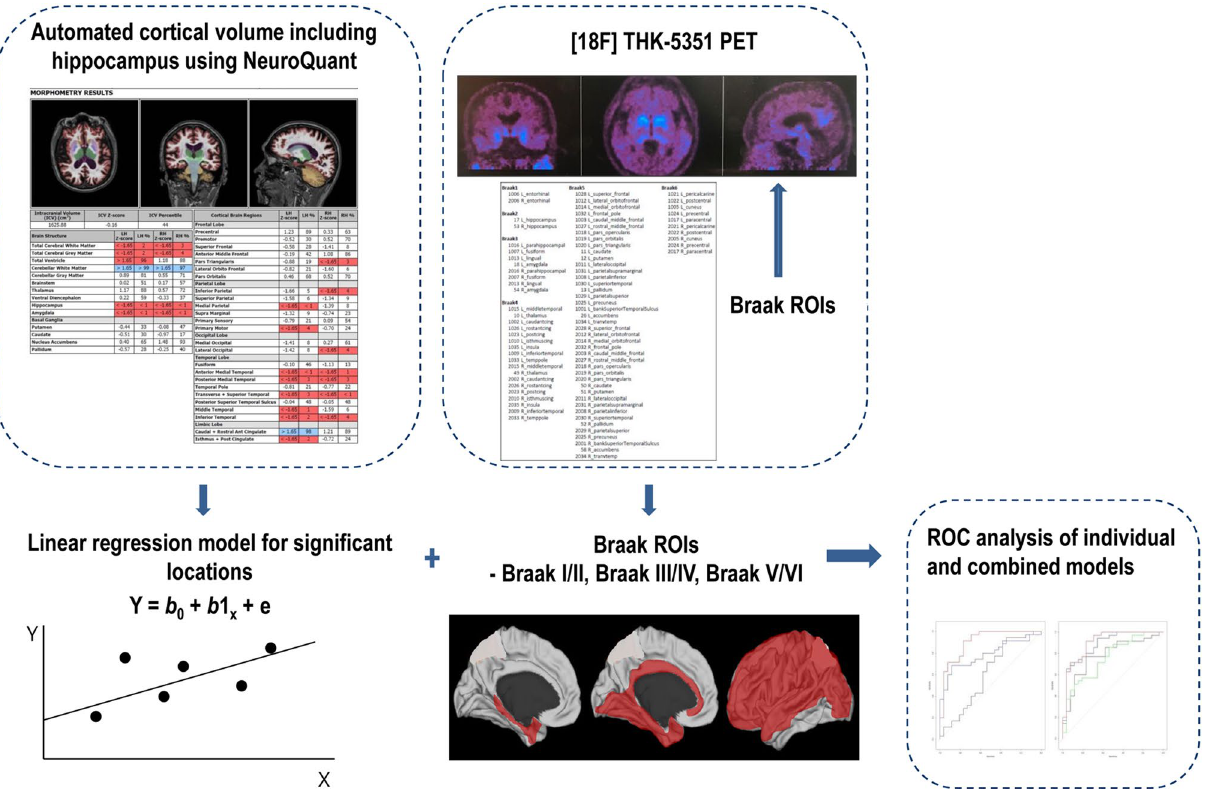
Figure 2. Overall process for image and statistical analysis. Automated MRI-volumetry analyses using NeuroQuant software package (CorTechs Labs, La Jolla, CA, USA, version 2.3, https:// www. corte chsla bs. com/ produ cts/ neuro quant/) were performed via the standard processing pipeline. The ROIs of [18F] THK-5351 PET images were segmented and expressed as Braak I/II, Braak III/IV and Braak V/VI. The performances of individual and combined models were calculated. ROI = region of interest, ROC = receiver operating